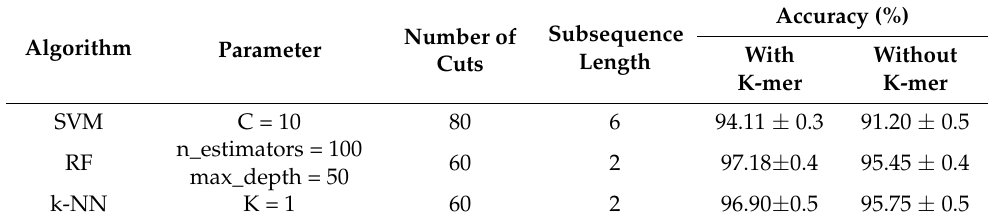
Table 3. Comparison analysis of HAR using various machine learning algorithms .